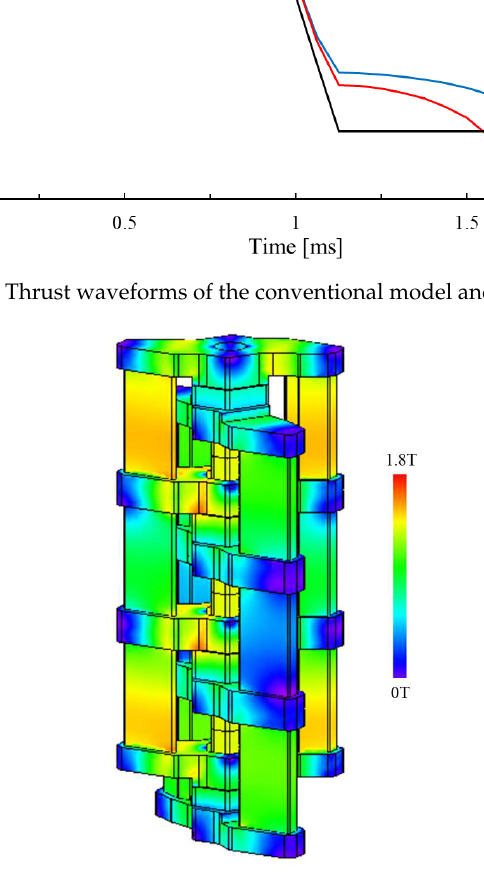
Figure 9. Magnatic flux density distribution.